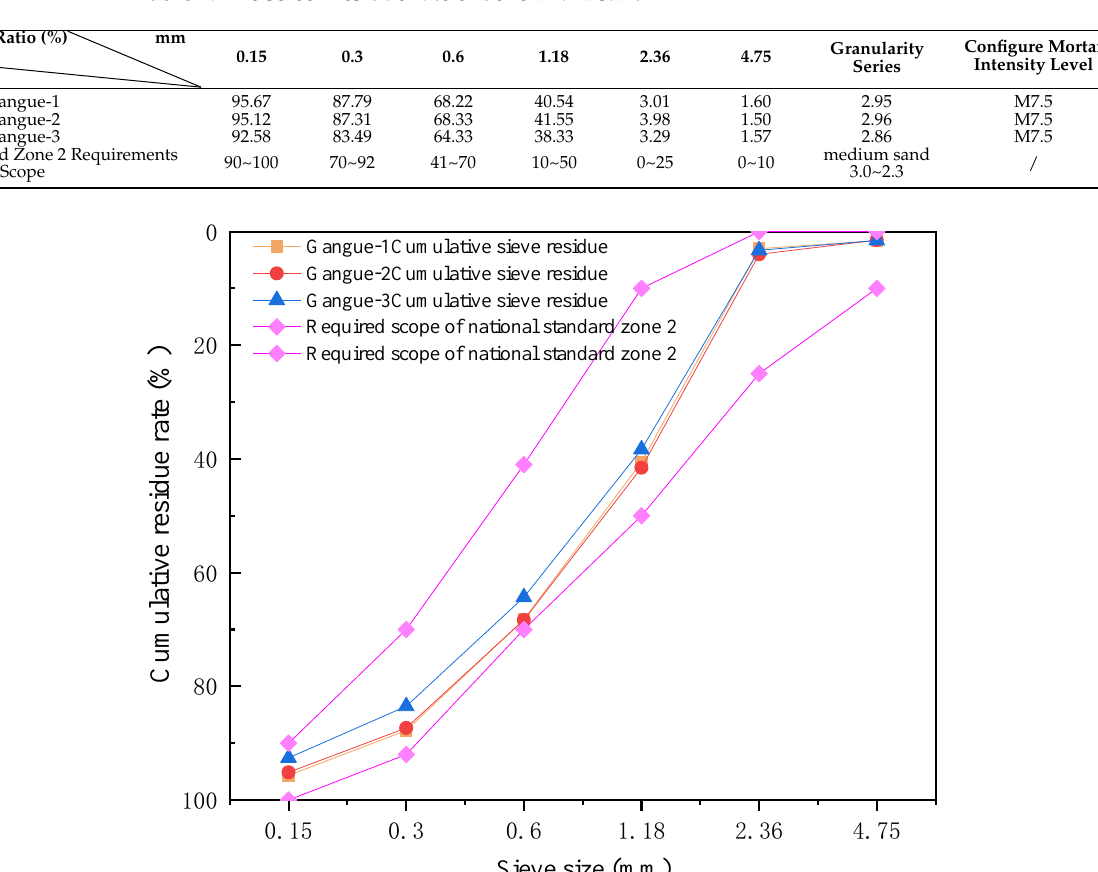
Figure 4. Particle grading curve of dry-mixed mortar.